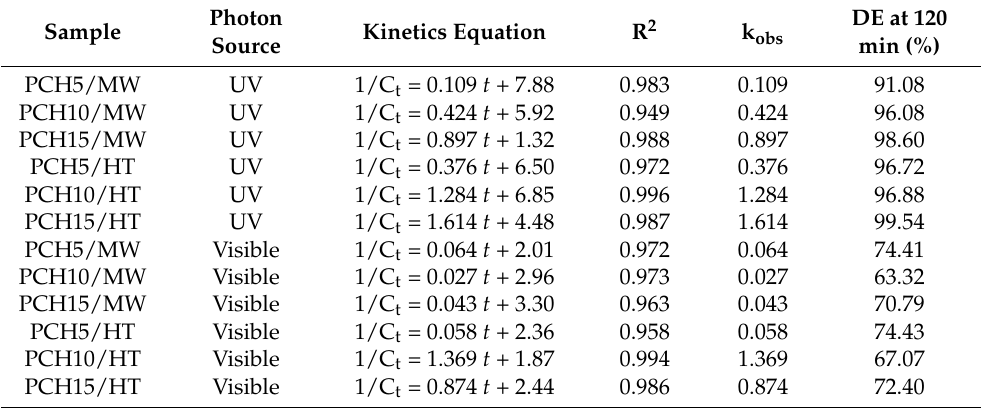
Table 3. Kinetics parameters and DE of MV photodegradation over various ZnO/SiO 2 -PCH sample.